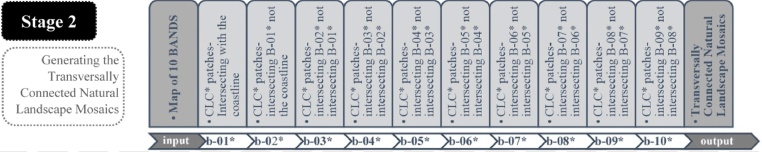
The detailed sequences of the Stage 2 of the workflow.